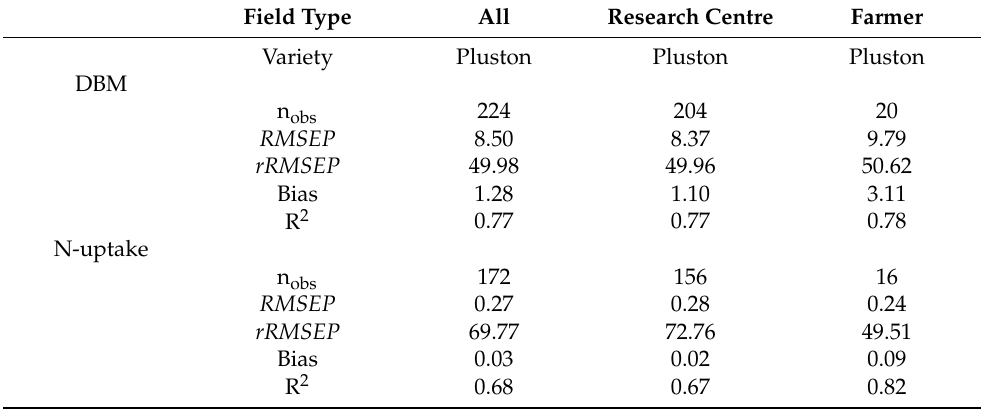
Table 5. Summary of the Lasso model to predict Pluston DBM and SLR model to predict Pluston N-uptake on the test data acquired during the 2020